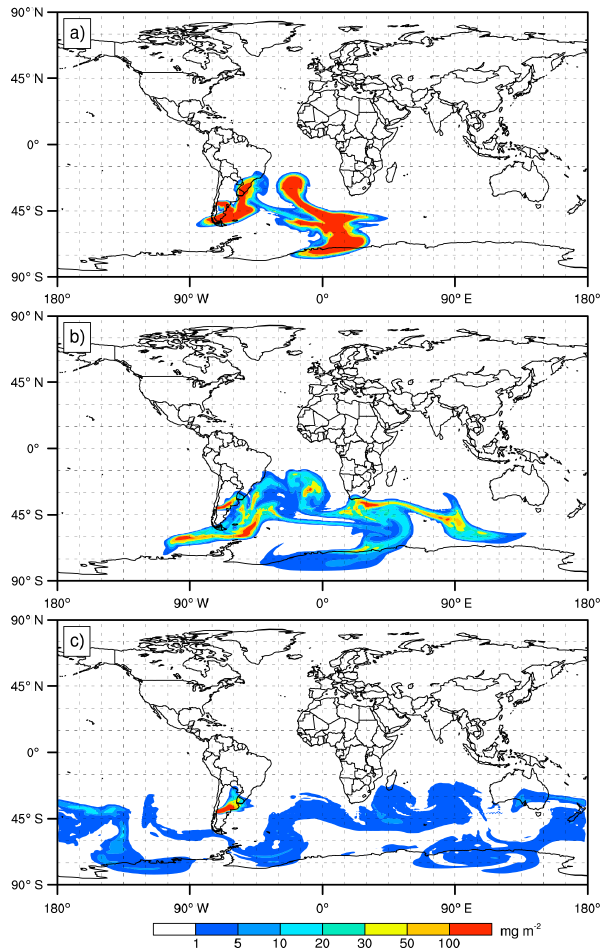
Figure 7. NMMB-MONARCH-ASH total column concentration (mass loading; mgm − 2 ) from our global simulation for the 2011 Caulle eruption. Results for (a) 8 June at 09:00UTC, (b) 10 June at 04:00UTC, and (c) 14 June at 06:00UTC.